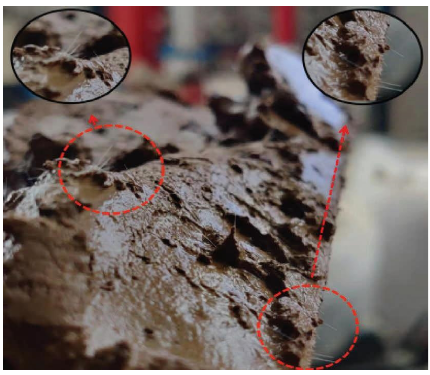
Figure 16: Te fber bundle phenomenon.